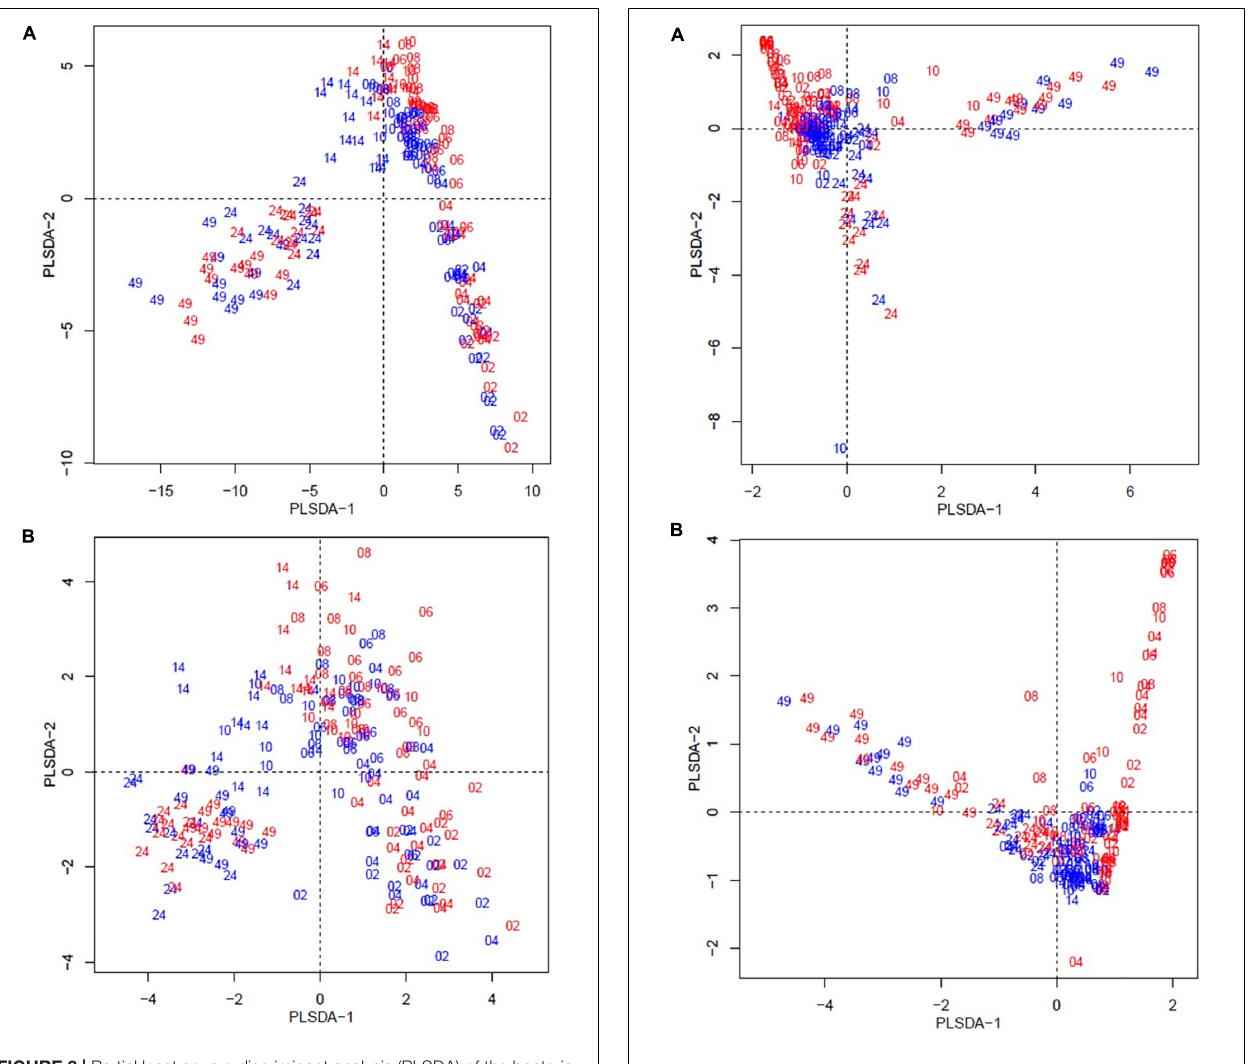
FIGURE 4 | Partial least square discriminant analysis (PLSDA) of the archaea community at the species level for treated (red) and control (blue) calves across sampling times. Calves during the rearing time were fed as follows: milk twice a day and ad libitum control and treatment concentrates at weeks 2 and 4; milk once a day and ad libitum control and treatment concentrates and partial mixed diet (PMR) diet at weeks 6, 8, and 10; concentrates step-down weaned and PMR diets fed ad libitum until week 14; and grazing a mixed sward of ryegrass/clover as one mob at weeks 24 and 49. Sampling times were from 2 to 49 weeks. (A) PLSDA of the archaea community – 17 archaeal species. (B) PLSDA of the abundant ( = 0.5 %) archaea community – 7 archaeal species. Calves from the treated and control groups are represented in red and blue, respectively. The numbers correspond to the sampling time in